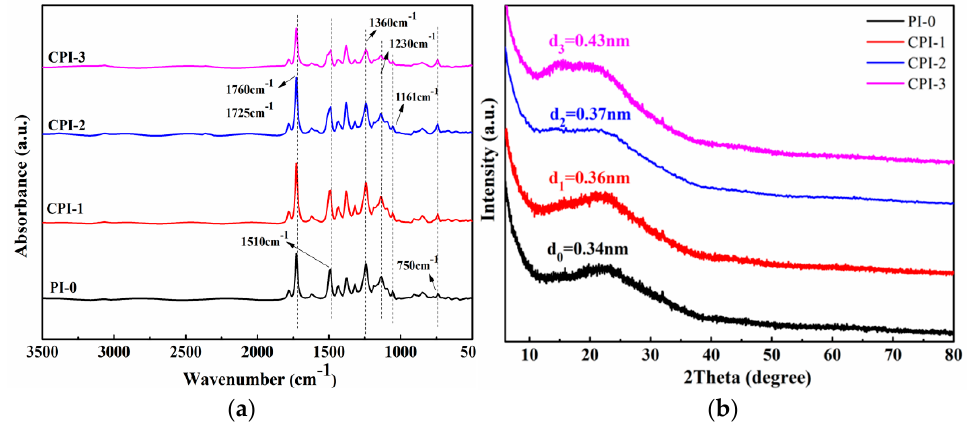
Figure 2. ( a ) ATR—FIR spectra and ( b ) XRD of the CPI films.